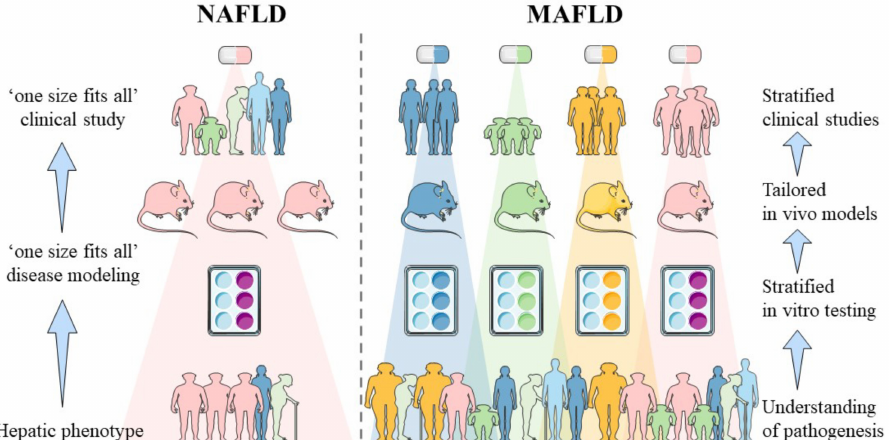
Figure 1. Impact of MAFLD nomenclature on different stages of drug development. Until now, patient inclusion for anti-NAFLD clinical studies was based on hepatic phenotype in the absence of significant alcohol intake and concurring pathologies. Anti-MAFLD trials will be undertaken based on pathogenic determinants that will likely require distinct pharmacological interventions. Introduction of the MAFLD terminology requires deeper understanding of the pathogenesis of fatty liver disease and hence necessitates the development of human-based in vitro models able to represent the distinct disease subsets. Disease subsets of MAFLD are indicated by the blue, green, yellow and pink colors. Corresponding in vitro tests, in vivo models, stratification in clinical studies and distinct pharmacological interventions are visualized by the same color for each disease subset. [Abbreviations: MAFLD: Metabolic-dysfunction associated fatty liver disease, NAFLD: non-alcoholic fatty liver